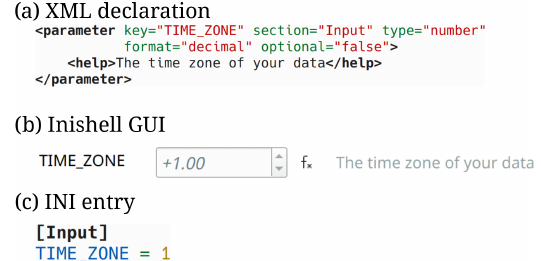
Figure 6. The basic building block for a numerical model configura- tion GUI, such as for integer entry. The panels show the declaration in the XML file, how it is shown in the GUI, and the generated INI file after user